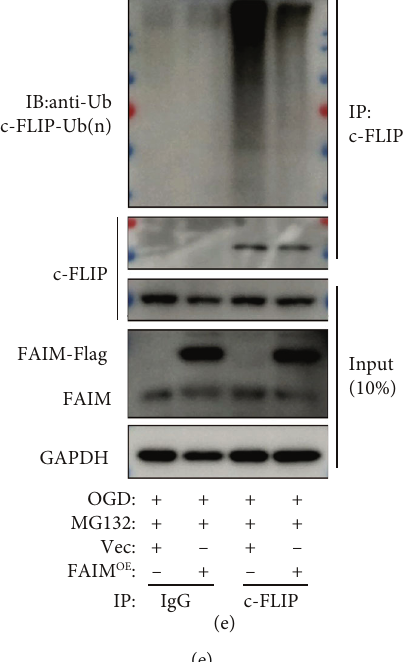
Figure 5: FAIM stabilizes the c-FLIP protein in MSCs by inhibiting its ubiquitination. (a) mRNA expression of c-FLIP in MSCs challenged with OGD. (b) Representative immunoblots showing c-FLIP protein expression in MSCs MSCs FAIM with 10 μ M CHX for the indicated times under OGD conditions. The results of densitometric quantitation are shown on the right, and the line chart shows c-FLIP protein levels (normalized to GAPDH) as a percentage of the c-FLIP protein expression of MSCs ( n = 3 ). (c) Representative immunoblots showing c-FLIP protein levels in MSCs indicated times under OGD conditions. The results of densitometric quantitation are shown on the right ( n = 3 ). (d) Representative Western blotting results showing c-FLIP protein expression after siRNA-mediated knockdown of FAIM or scrambled siRNA administration followed by treatment with chloroquine (CQ, 50nM) or MG132 (10 μ M) under OGD conditions. The results of densitometric quantitation are shown below ( n = 3 ). (e) MSCs conditions for 6 h. Whole-cell lysates were immunoprecipitated with anti-FLIP antibodies, followed by immunoblotting with anti- ubiquitin antibodies. The input (10% of the total) was analyzed by Western blotting using anti-FLIP and anti-FAIM antibodies. The data are shown as the mean ± SD . Ns indicates not signi fi cant; ∗ denotes P < 0 : 05 ; ∗∗ P < 0 : 01